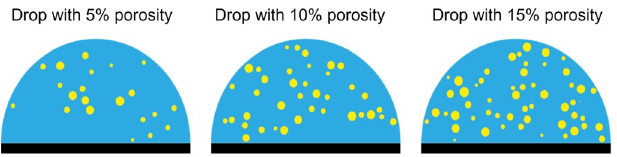
Figure 3. Drops with different values of porosity. Water and pores are represented in blue and yellow,